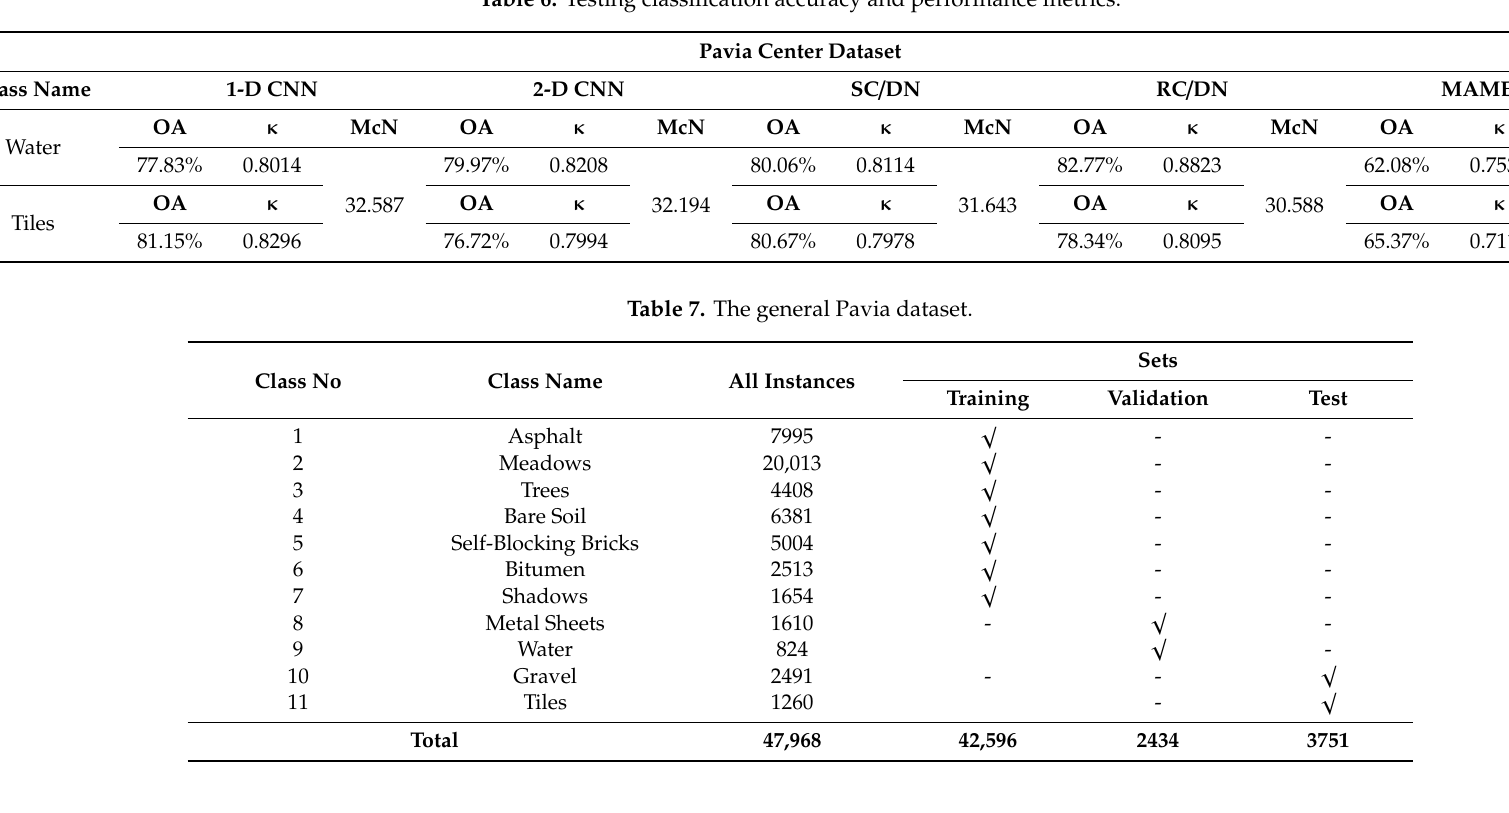
Table 6. Testing classification accuracy and performance metrics.